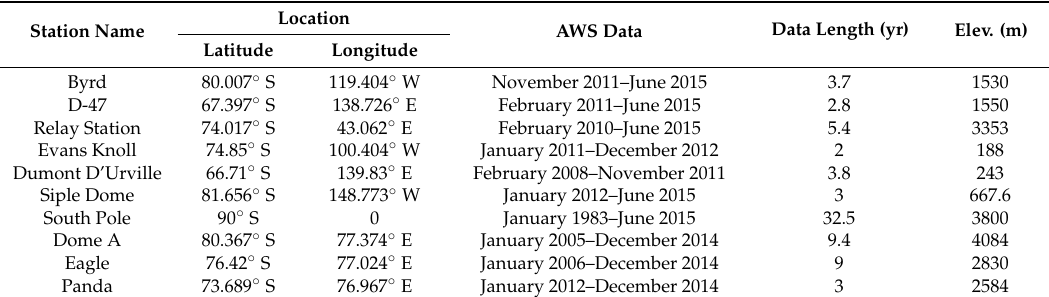
Figure 1. Map of Antarctica showing the locations of the 10 automatic weather stations (AWSs). The different colors show the different ranges of annual surface mass balance (SMB). Time coverage varied between stations, as shown in Table 1. Table 1. Locations, lengths of records, and elevations of the AWSs.